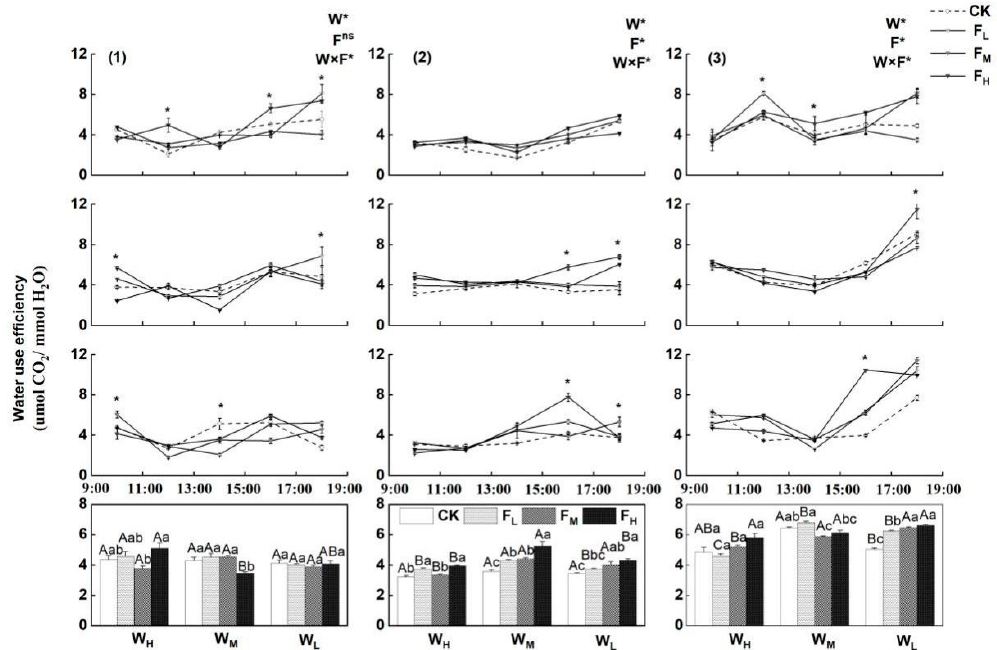
Figure 9. Changes in WUE values of test plant species under different water–fertilizer treatments. Numbers ( 1 ) − ( 3 ) in brackets indicate P. crymophila , F. coelestis , and S. purpurea , respectively. W, F, and W × F indicate the results of ANOVAs ( p < 0.05) for the effects of water, fertilizer, and their interactions. Asterisk (*) and ns indicate significant difference and non-significant. The uppercase letters and lowercase letters represent the difference between water and fertilizer treatments.